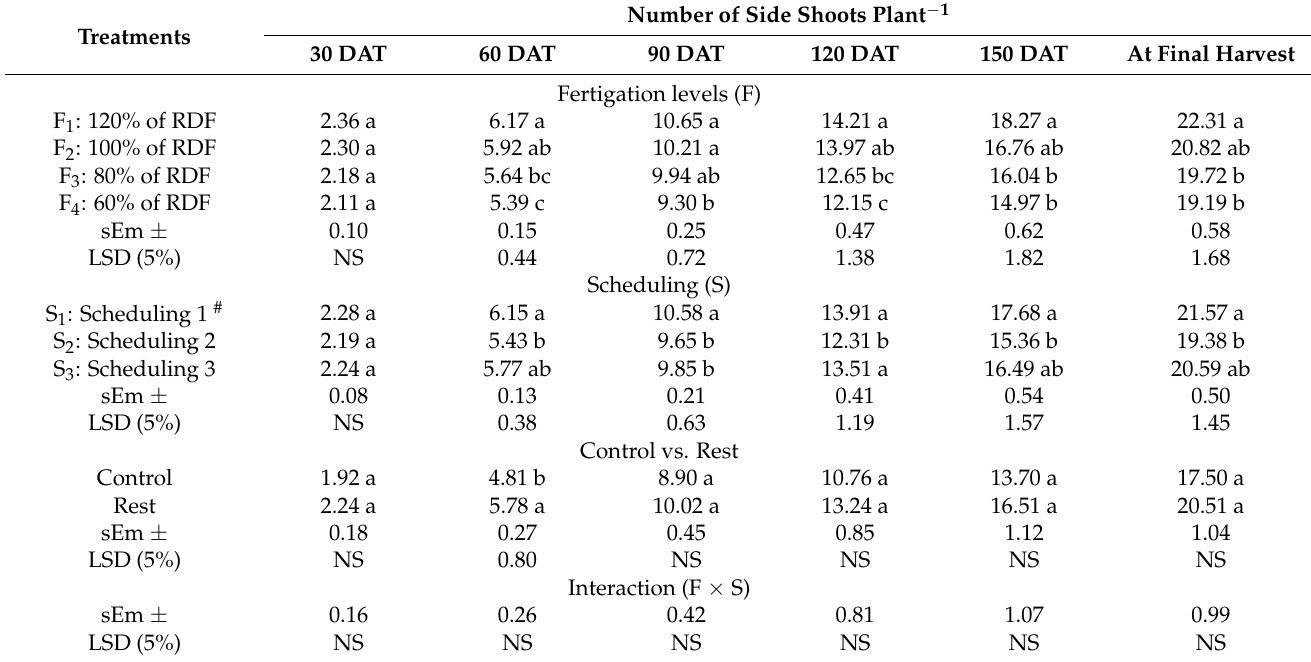
Table 4. Number of primary branches per plant as affected by fertigation levels and scheduling at different growth stages of tomato (2-years pooled data).